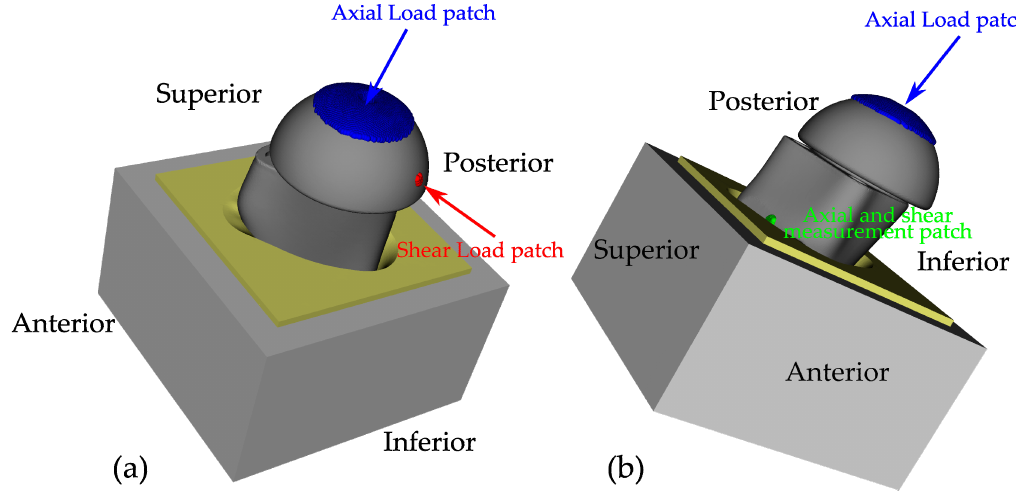
Figure 2. Left ( a ), isometric view of the finite element (FE) model with a shear load applied inferiorly. In blue the patch defined for the application of the axial load, in red the shear load patch. Right ( b ), superior view of the FE model. In green the measurement patch defined to calculate the baseplate